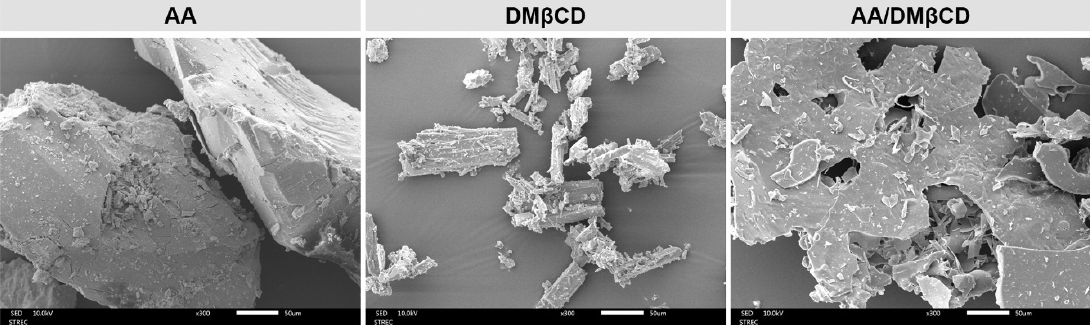
Figure 6. SEM photographs of the AA, DM β CD, and AA/DM β CD complex.